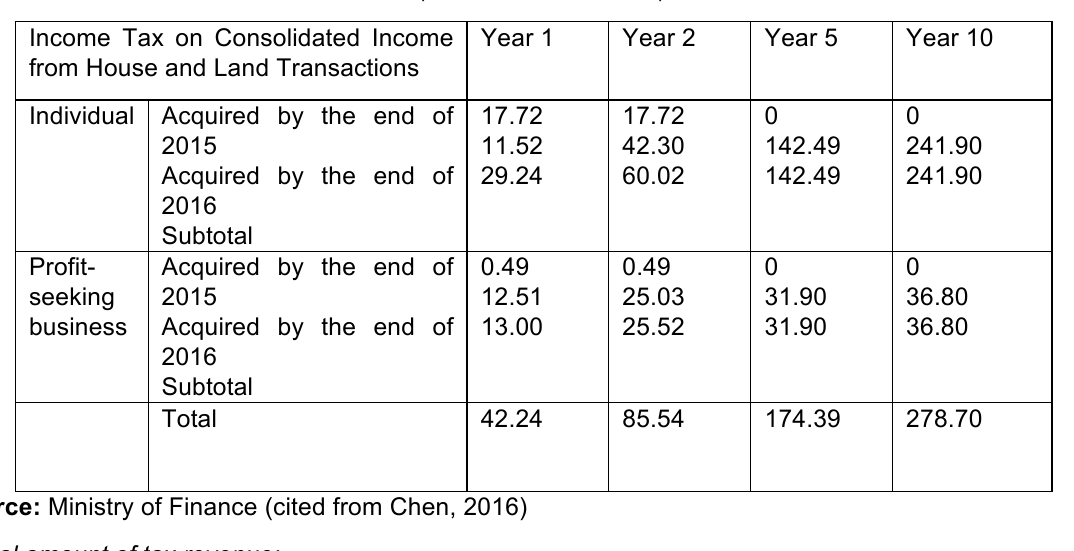
Table 1: Assessment of impact on tax revenue (Unit: NT$ 100